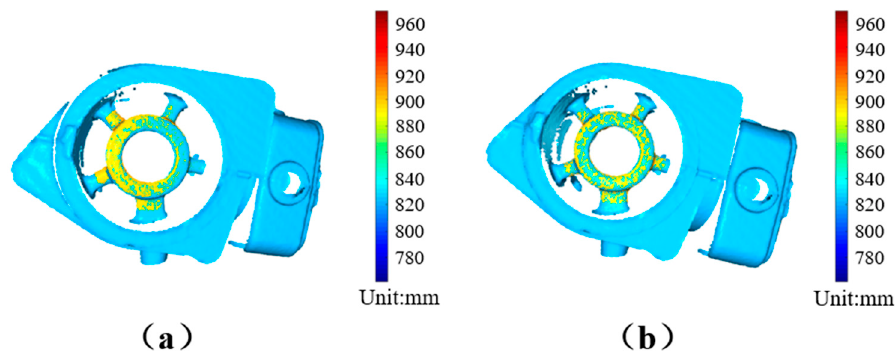
Figure 11. Coarse and fine registration renderings. ( a ) Coarse alignment effect. ( b ) Precision matching accurate effect.